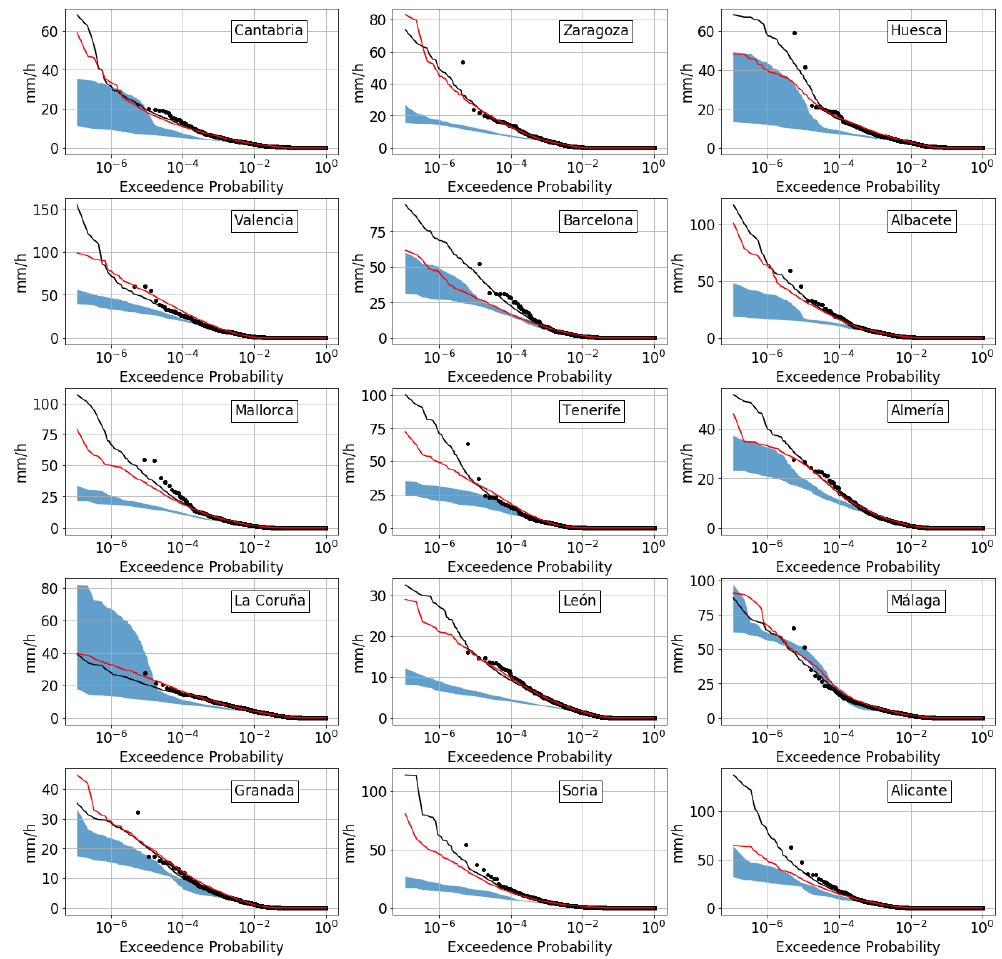
Figure 8. Empirical intensity-frequency curves derived from observed and simulated rainfall at 1-h aggregation. Black dots represent exceedance probability values of the observed rainfall series. Black and red lines correspond to the exceedance probability of “exact scenario” and “target scenario”, respectively. The blue-colored area represents the range of exceedance probability values between the 10 calibrations in the “simple scenario”. Each panel corresponds to a case